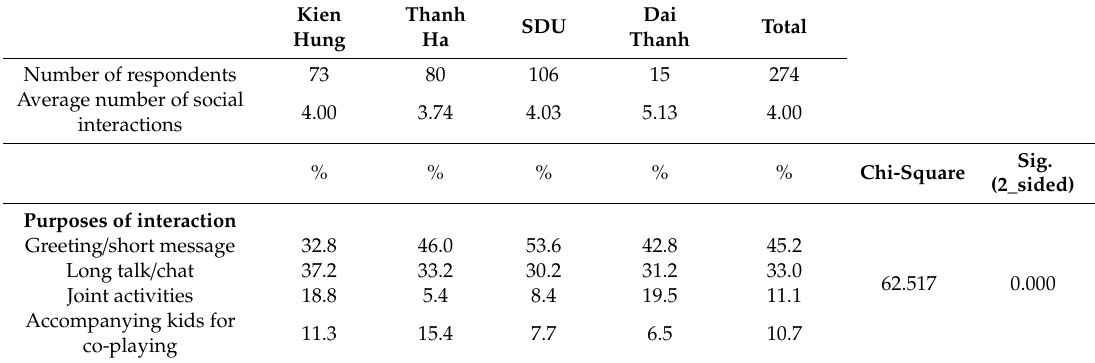
Table 3. Main purposes, spaces used and importance by number of social interactions. Kien Thanh Dai SDU Total Hung Ha Thanh Number of respondents 73 274 Average number of social interactions